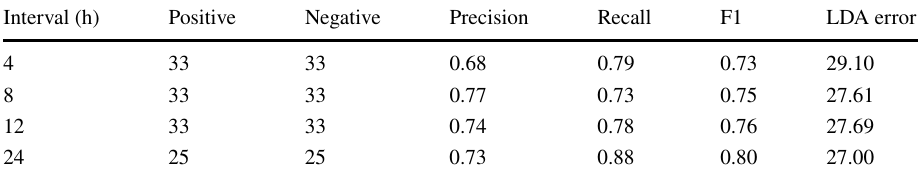
Table 2 The results: Martin criterion [3]